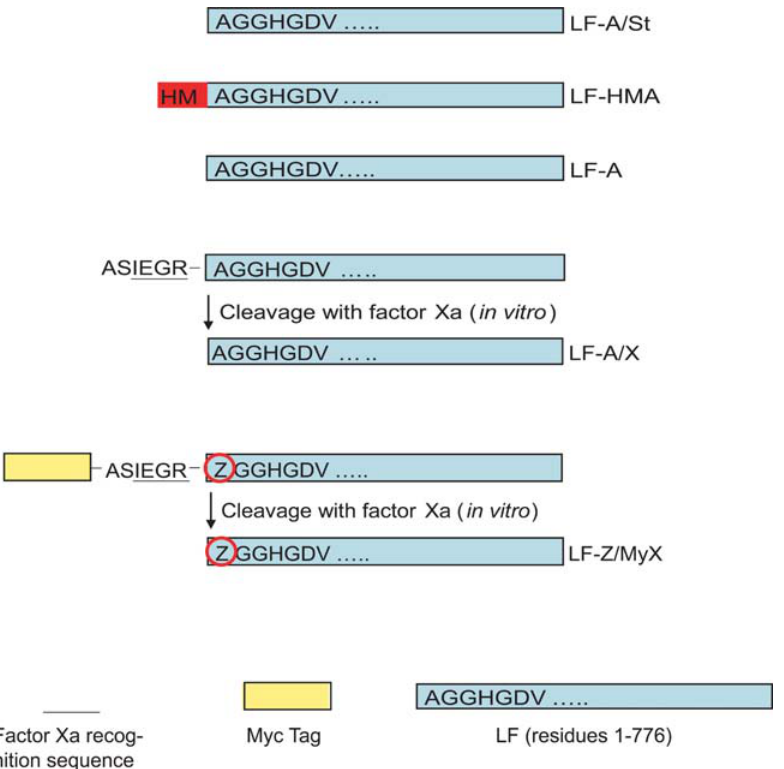
Figure 1. Schematic representation of various LF proteins. All proteins (except LF-A/St which is wild type LF produced from Sterne strain) were generated as secreted proteins from B. anthracis BH450. All proteins contained a signal peptide that is cleaved by signal peptidases during secretion. Constructs with a factor Xa recognition sequence alone or preceded by the Myc epitope tag are labeled ‘‘/X’’ or ‘‘/MyX’’, respectively. These proteins were produced as precursor proteins followed by cleavage with factor Xa protease to generate the indicated N-termini. Residue (Z) circled in red indicates the residue mutated for each protein, i.e., Z=A, H, M, R, F, G in different mutated LF constructs.